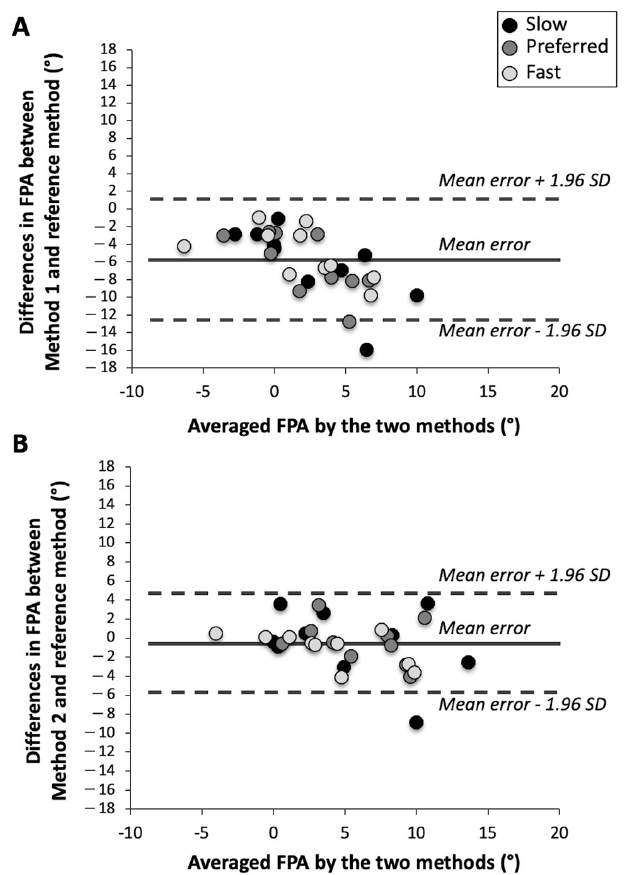
Figure 3. Bland and Altman plot of differences between the reference method and both force-plate methods: Method 1 ( A ) and Method 2 ( B ). Solid line represents the mean error. Upper and lower horizontal dotted lines represent the limits of agreement (mean ± 1.96 standard deviation (SD) of the error between methods).